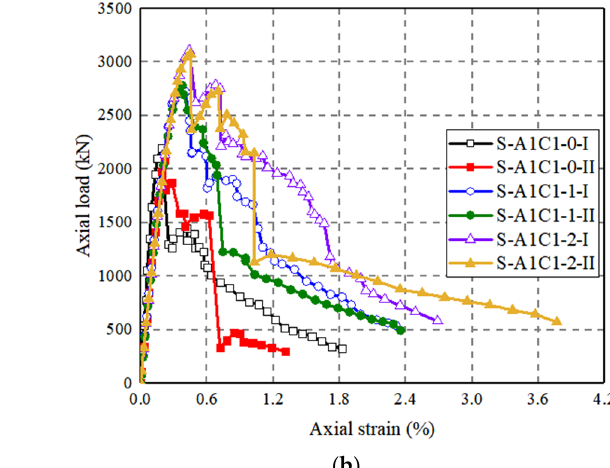
Figure 12. Effect of number of FRP grid layers on the axial load–strain curves.